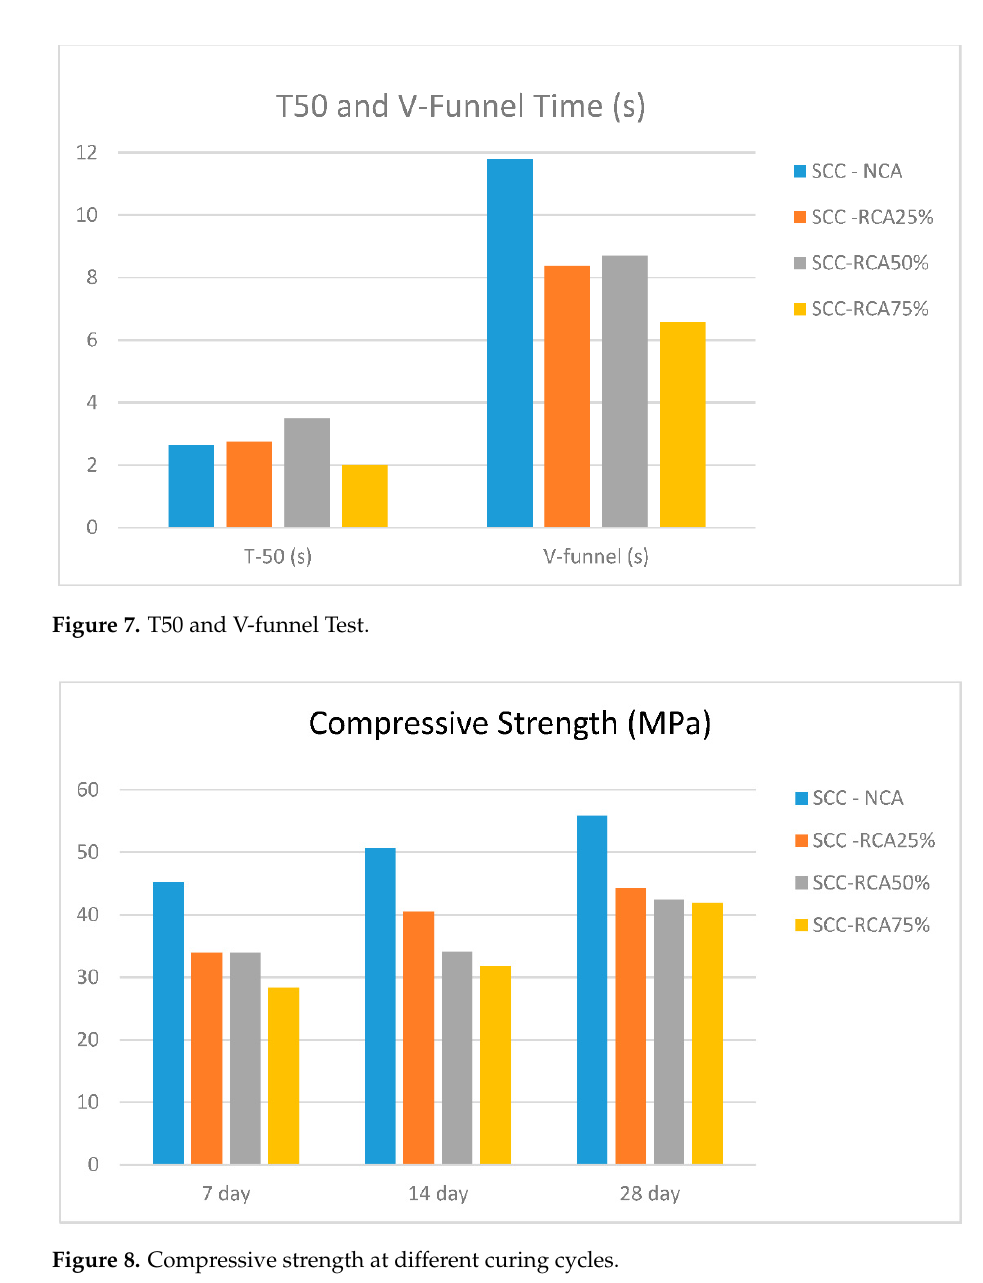
Table 4. Compressive strength deviation assessment. Mix